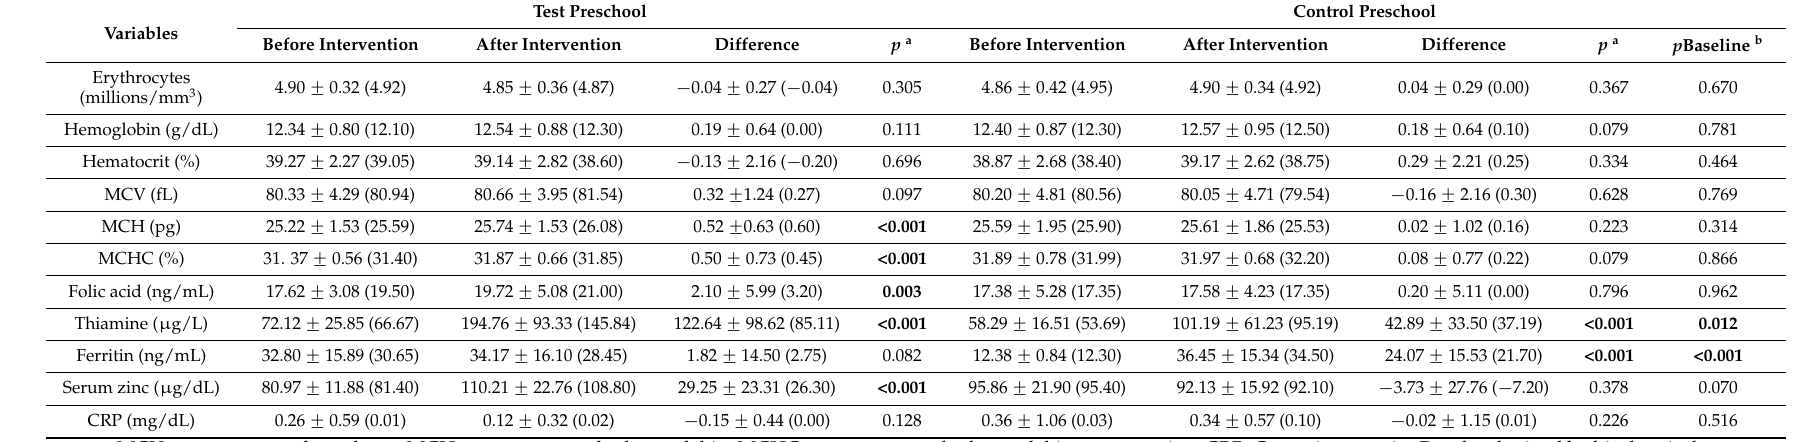
Table 3. Biochemical variables of preschool children in the test and control groups, before and after the